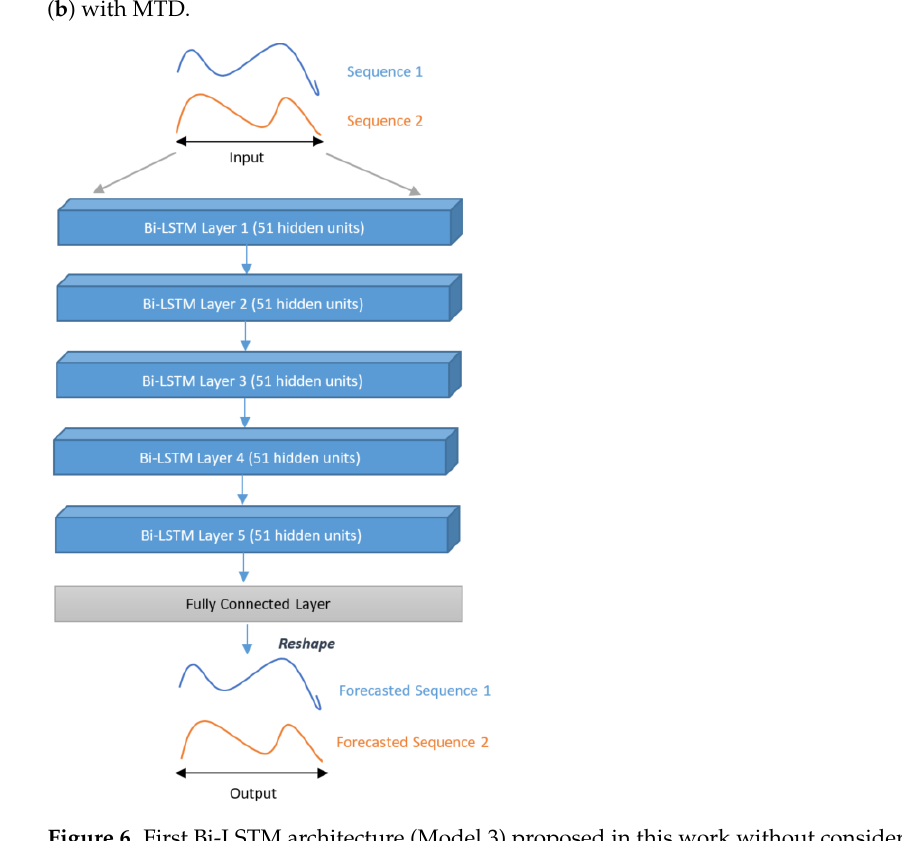
Figure 5. LSTM architectures (Model 1 and Model 2) proposed in this work: ( a ) without MTD;